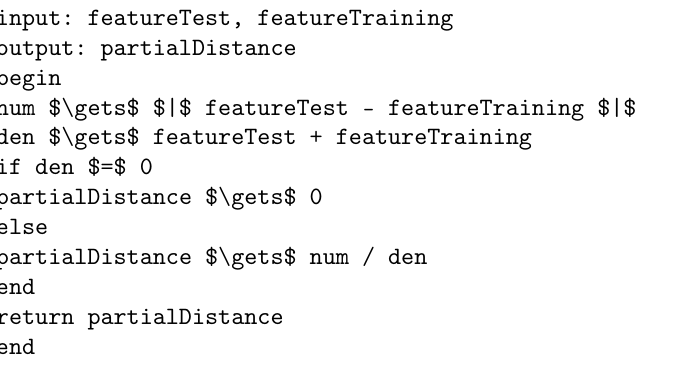
Figure 7. Pseudo-code of Canberra